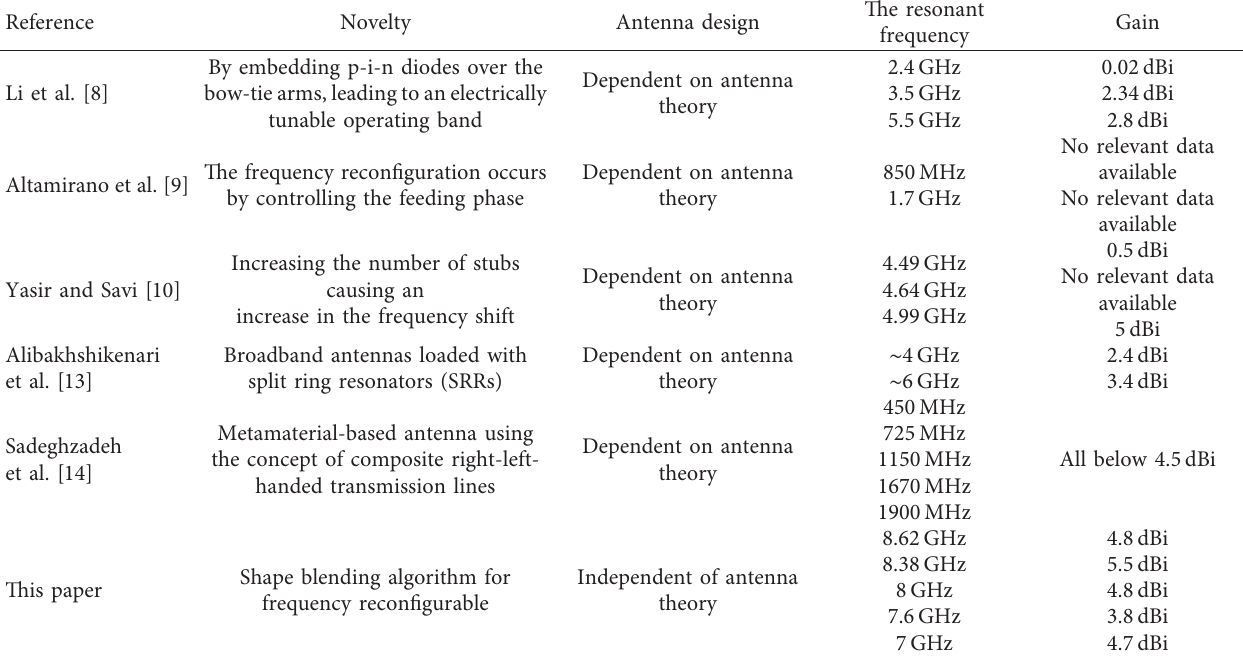
Table 1: Comparison between the proposed antennas with the recent